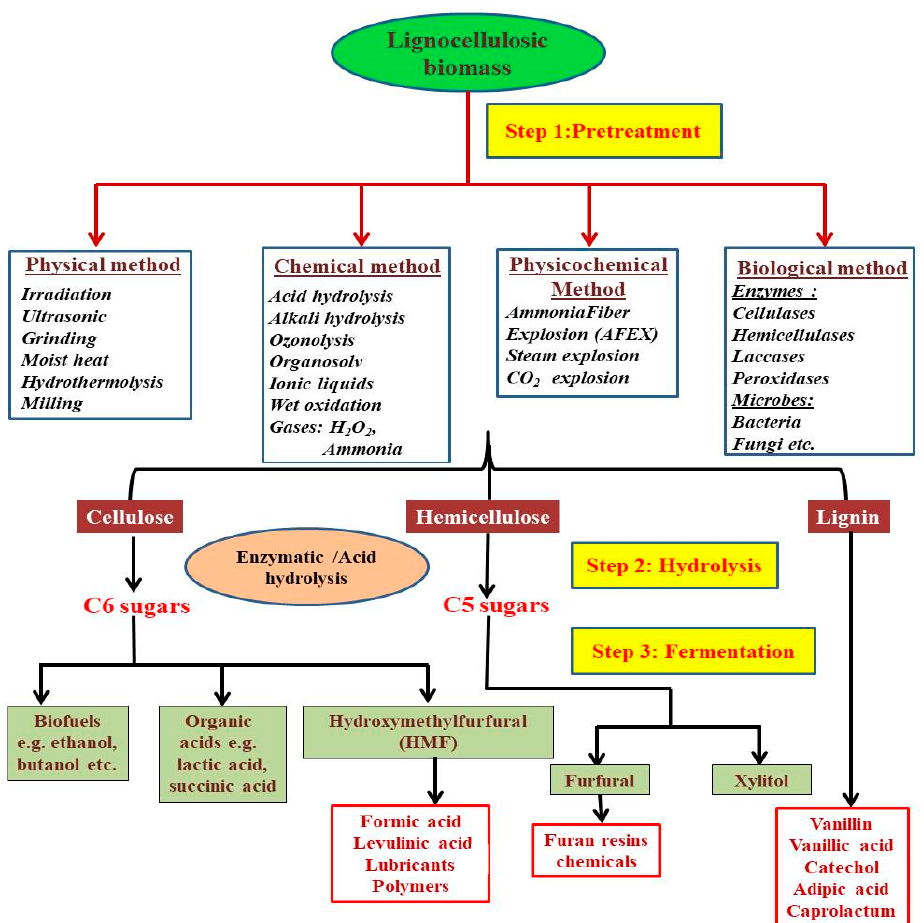
Figure 1. Three step process of lignocellulosic biomass conversion into various value-added products.